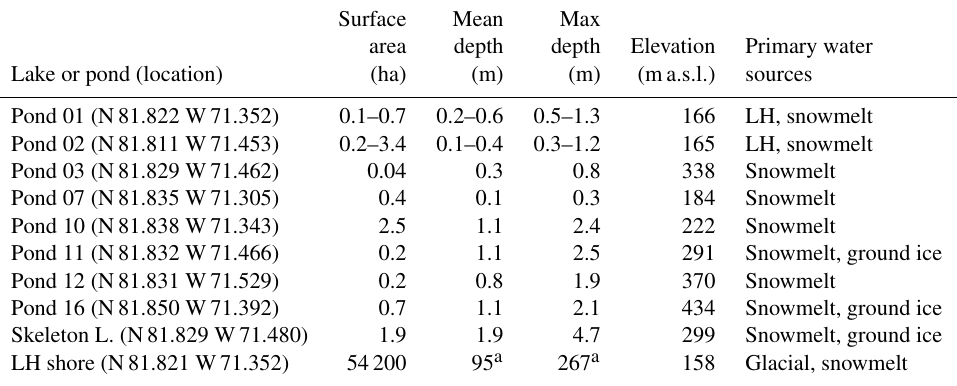
Table 1. Morphometry and hydrology of ponds and lakes sampled for dissolved greenhouse gas concentrations and general chemistry in the Lake Hazen (LH) watershed during the growing seasons (June–August) of 2005 and 2007–2012.